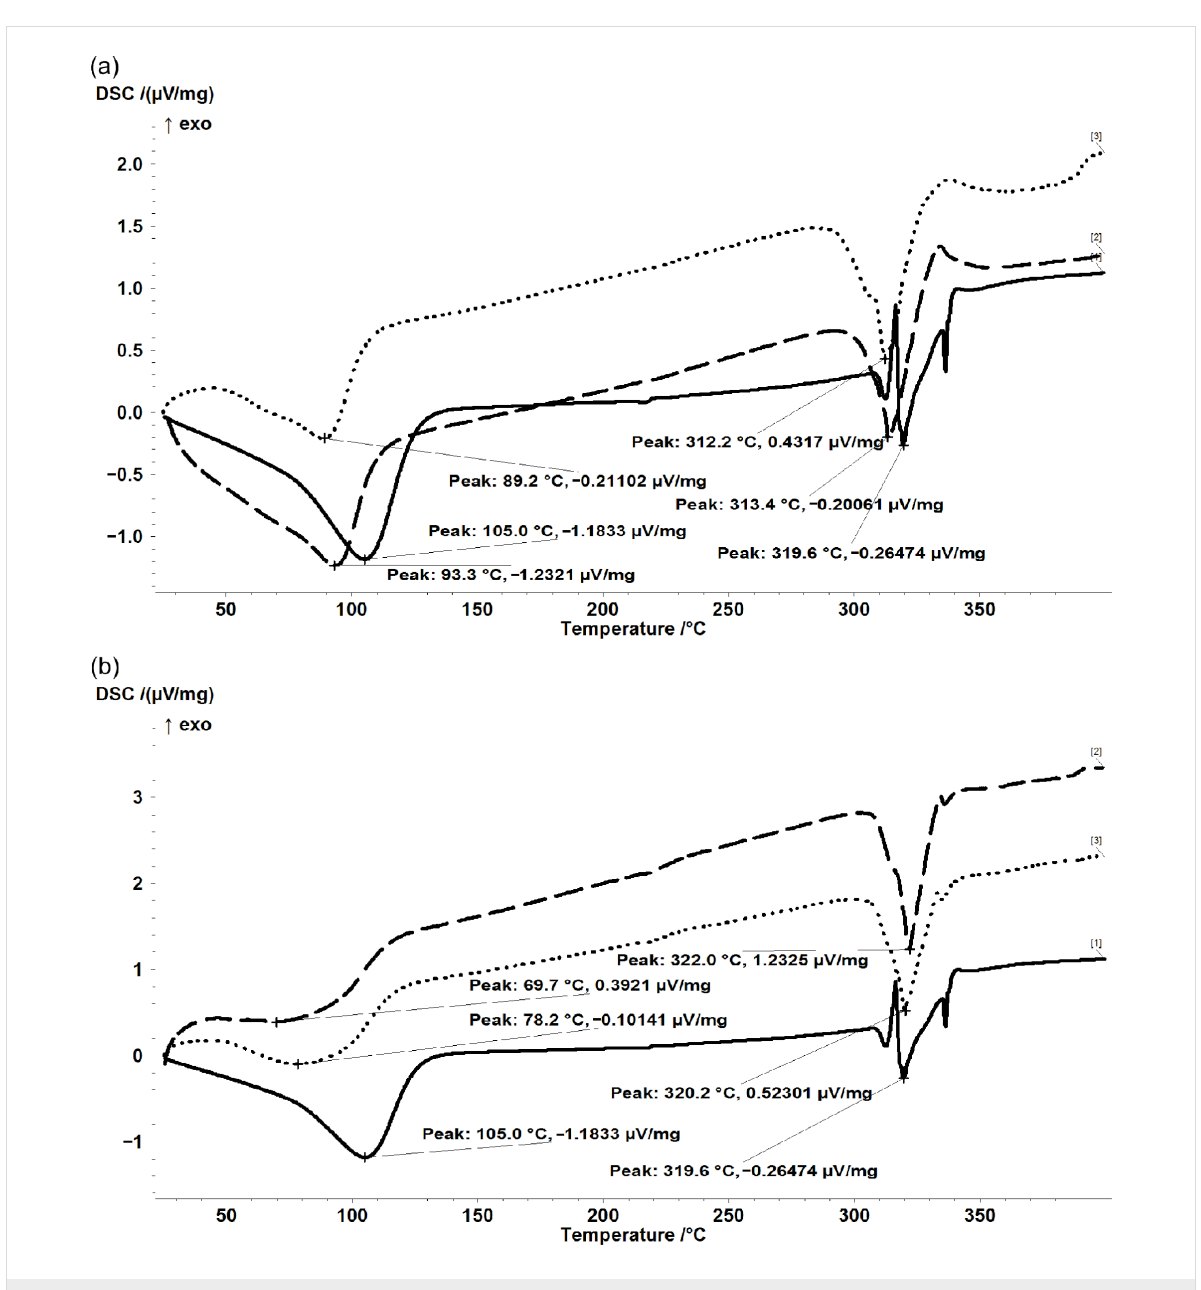
Figure 2: Superimposed DSC data for β -CD (solid line) and (a) β -CD/ASO_3:1_a&b (duplicate) or (b) β -CD/ASO_3:1(k)_a&b (duplicate). For sample name abbreviations, see Table 3.